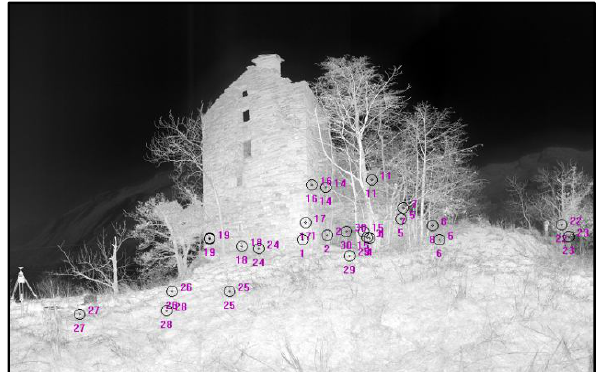
Figure 4 . Point cloud georeferentiation through the markers (Osello, E.,